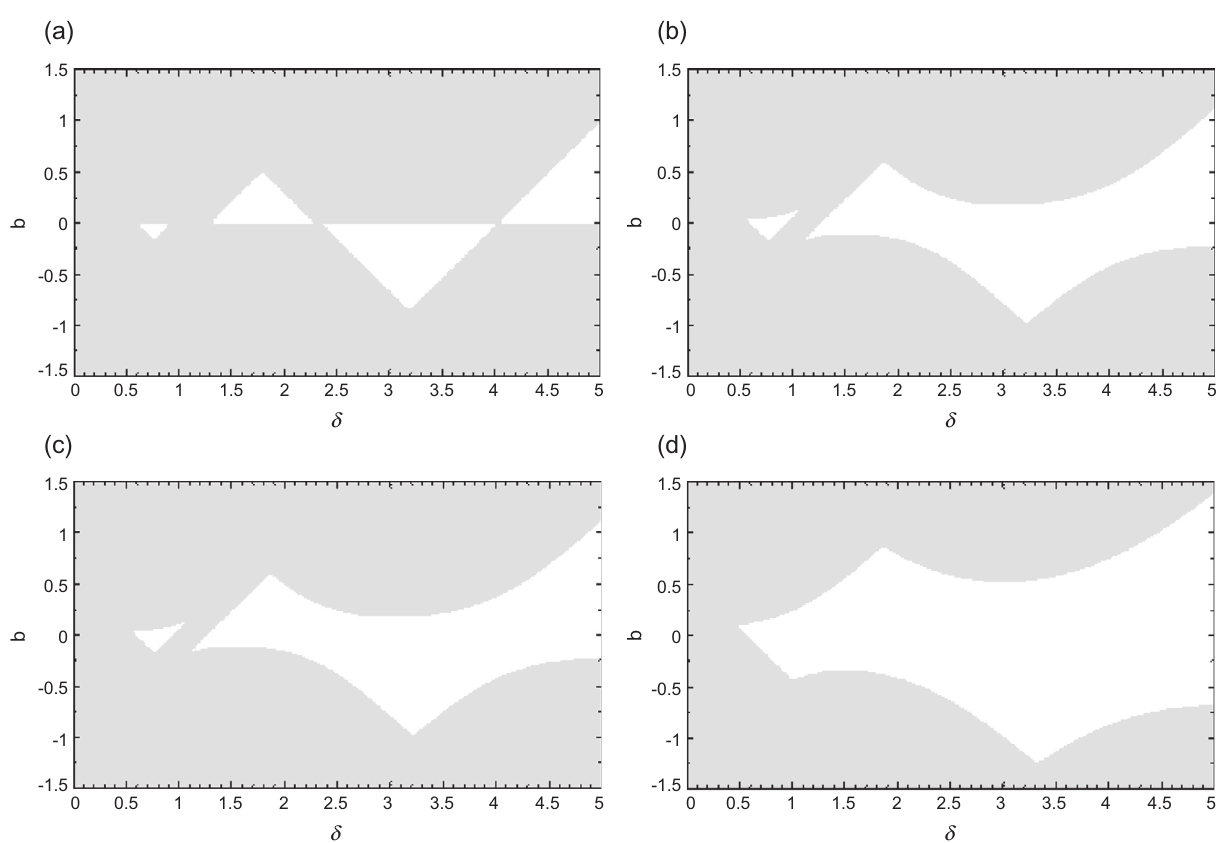
Figure 9. Stability charts of equation (55) from PTRMPA with (cid:2) = 1, x = 1 when (a) damping coefficient j = 0, (b) j = 0.1, (c) j = 0.2 and (d) j = 0.3. The sub-domains of stability are white while those of instability are